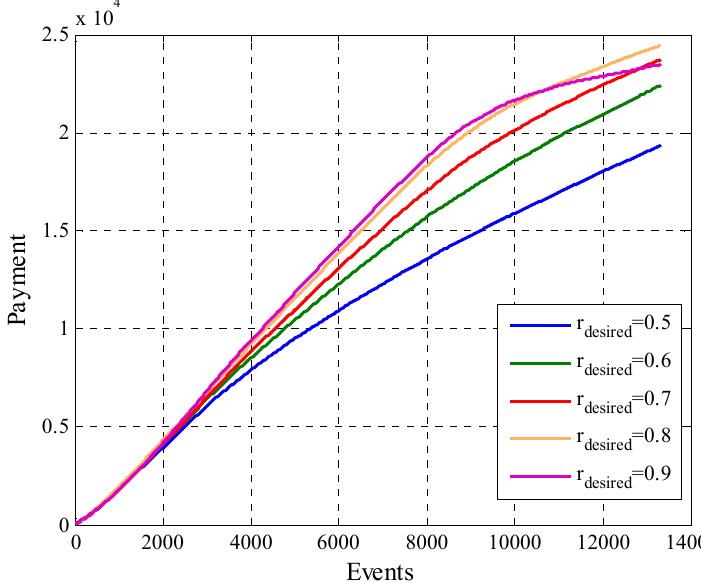
Figure 25. Total Payment for configurations with di ff erent values of r desired .